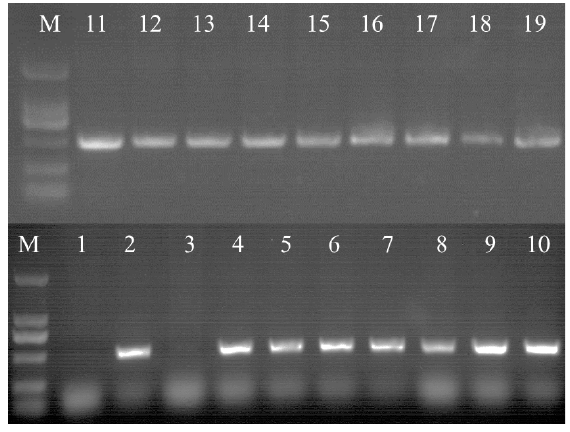
Figure 7. PCR analysis of HPT (500 bp) in transgenic cell lines. M: DNA Marker DL 2000. 1: negative control (non-transgenic cell line); 2: positive control (vector carrying the HPT gene); and 3–19: transgenic cell lines.